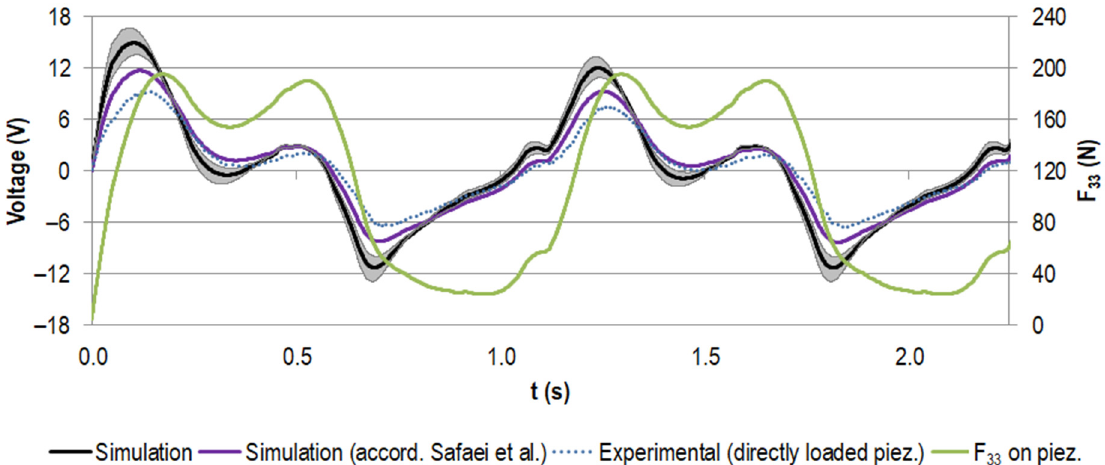
Figure 8. Generated voltage (V) for the first two gait cycles (time t in s) for the stacked configuration at a load resistance R of 0.5 M Ω , assuming the capacity provided by the manufacturer (in black, with tolerance of ±20% in grey) and the capacity calculated according to Safaei et al. [56,57] (in purple). Experimental data for the directly loaded piezoelectric element are shown in blue (dotted line). The scaled load profile F 33 (N) as the basis for the simulation and as input for the uniaxial testing machine is displayed in green.